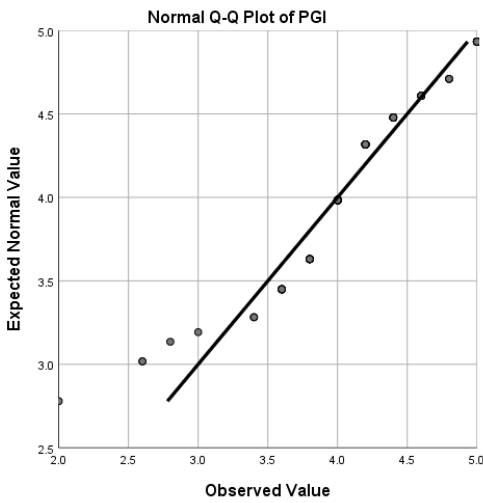
Figure 2. Quantile-quantile (Q-Q) plot for distribution of PGI scores.